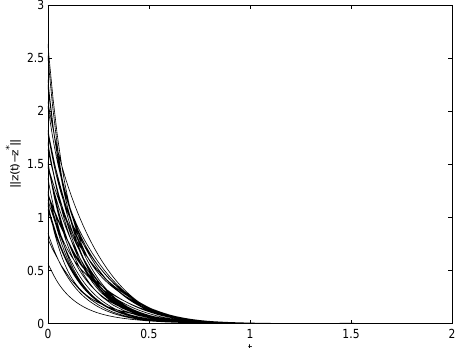
Fig. 2. Convergence behavior of the error (cid:5) z ( t ) − z ∗ (cid:5) based on (3)-(4) with 30 random initial points in Example